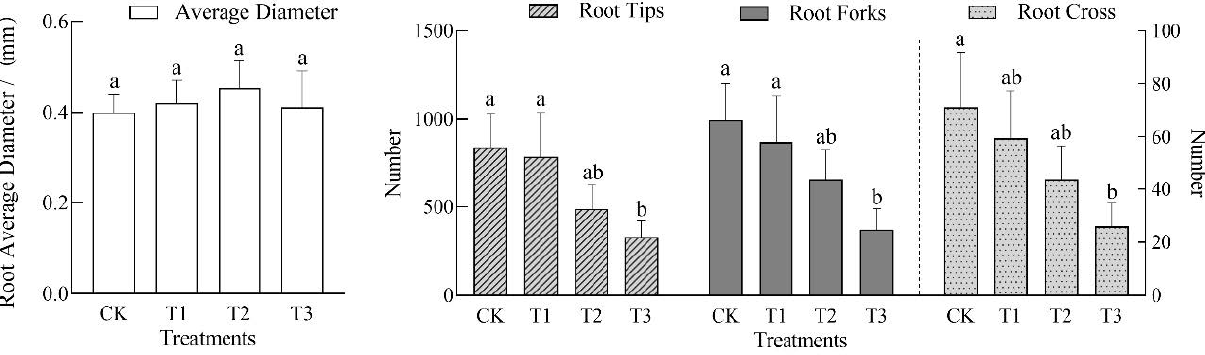
Figure 3. Effects of different treatments on root length, volume, and area of tobacco. Note: Different lowercase letters indicate that the differences between treatments reached a significant level ( p < 0.05).